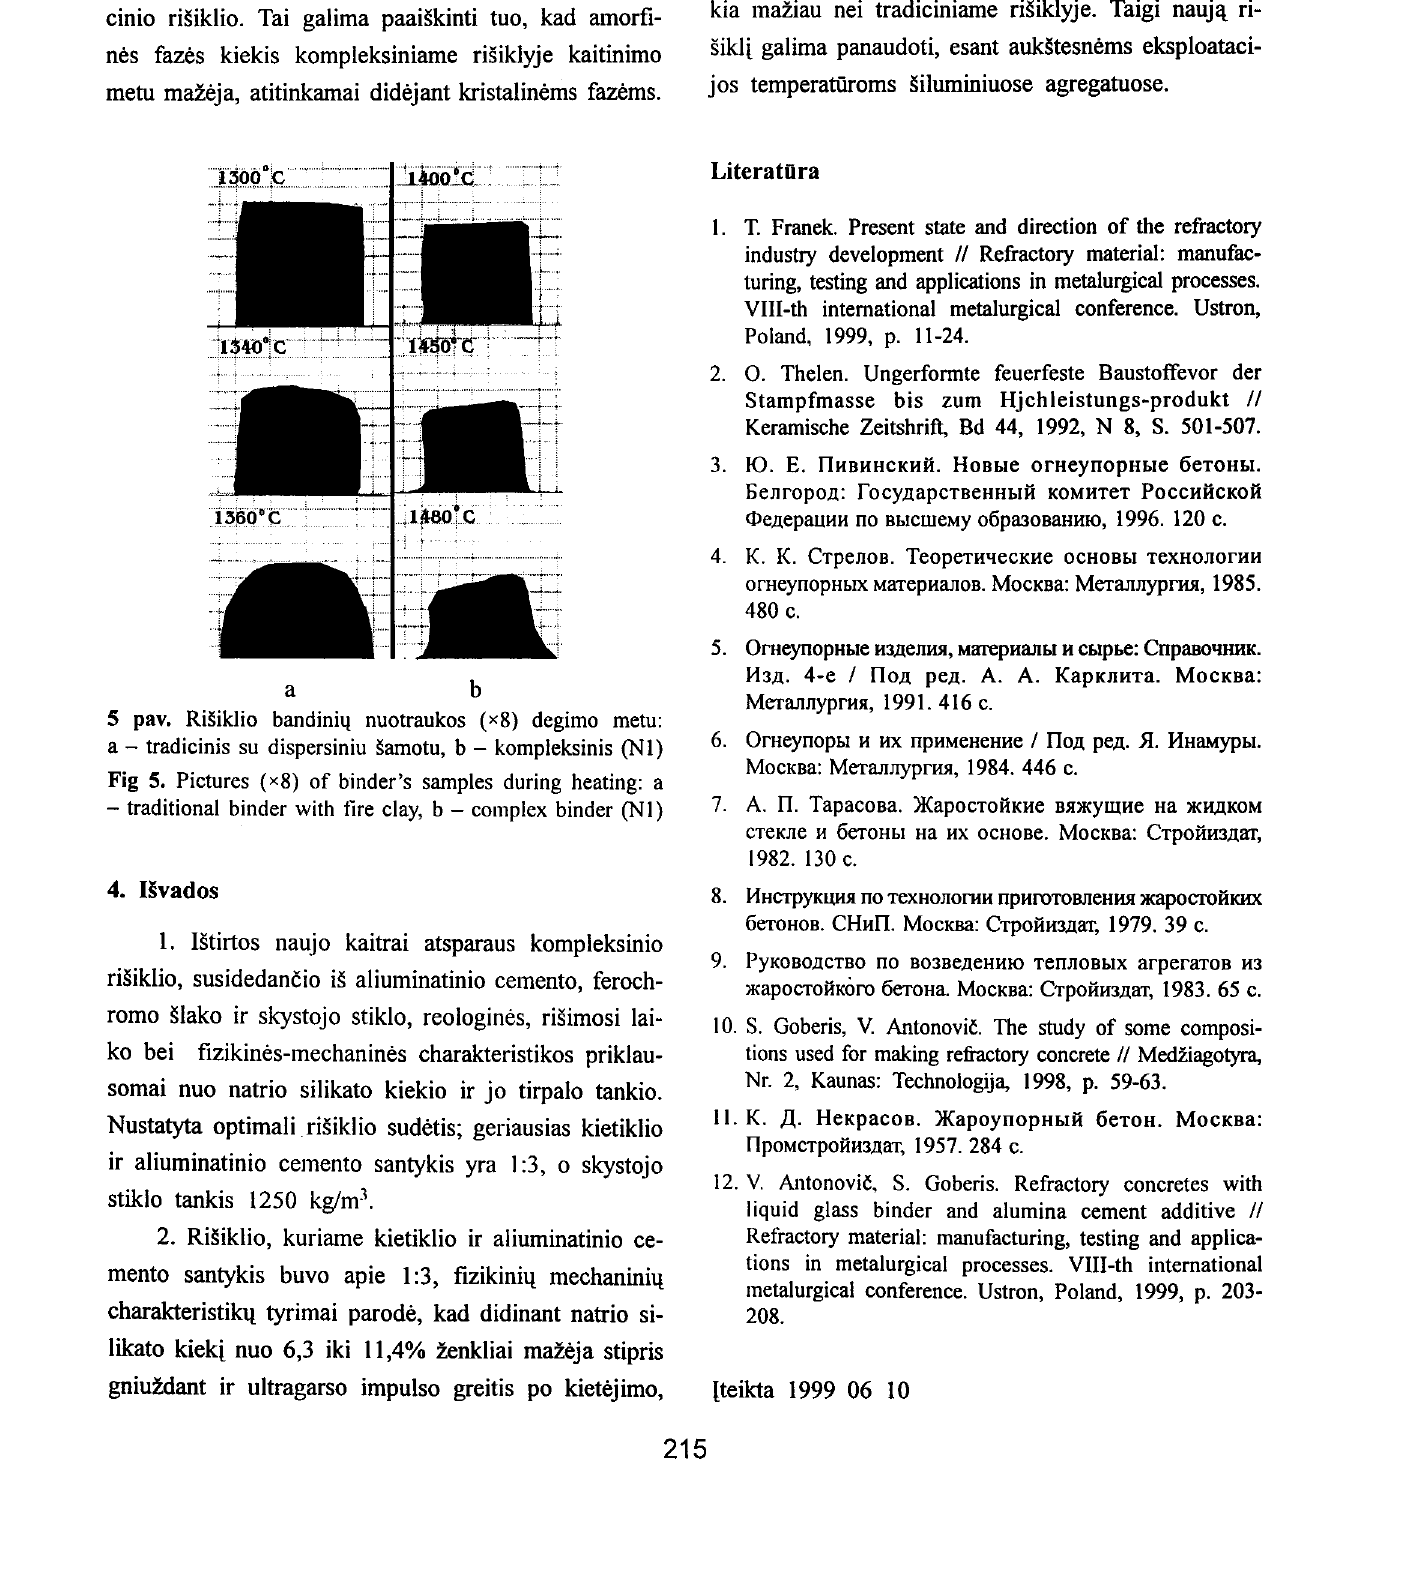
Fig 5. Pictures (x8) of binder's samples during heating: